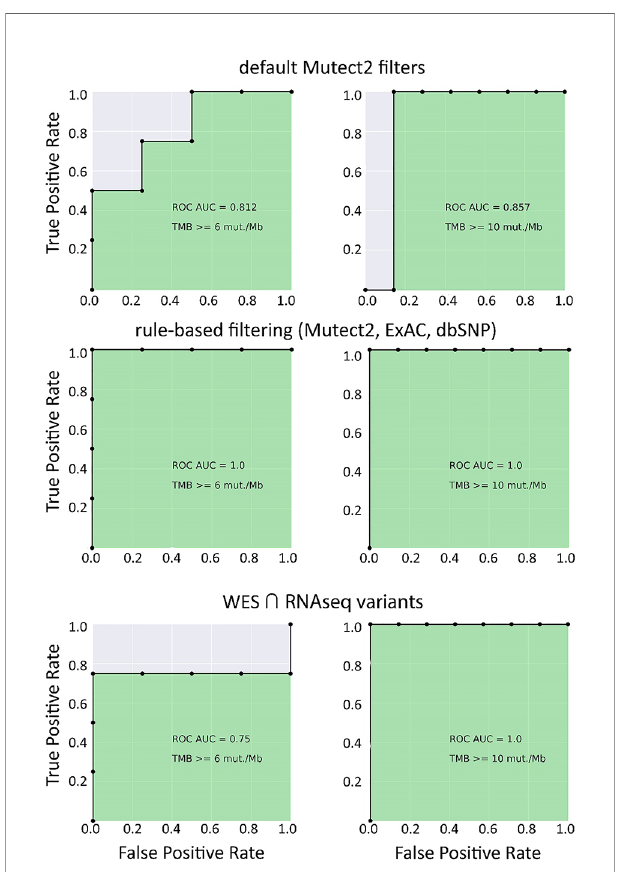
FIGURE 11 | ROC AUC scores for predicting WES-TMB per megabase with RNAseq-TMB per megabase (experimental high coverage transcriptomes, n =